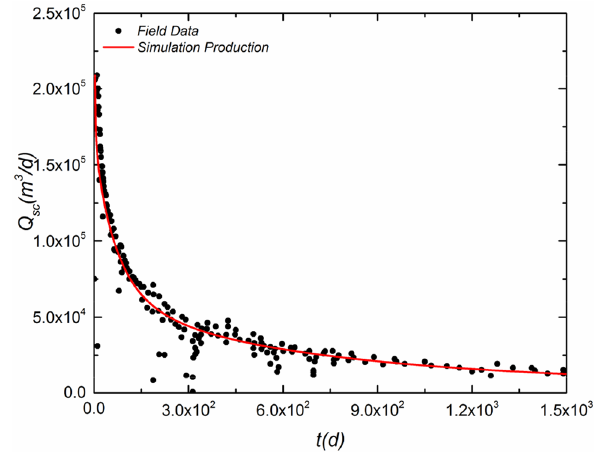
Fig. 3 Comparison between the new model and the classic dual- porosity trilinear flow model